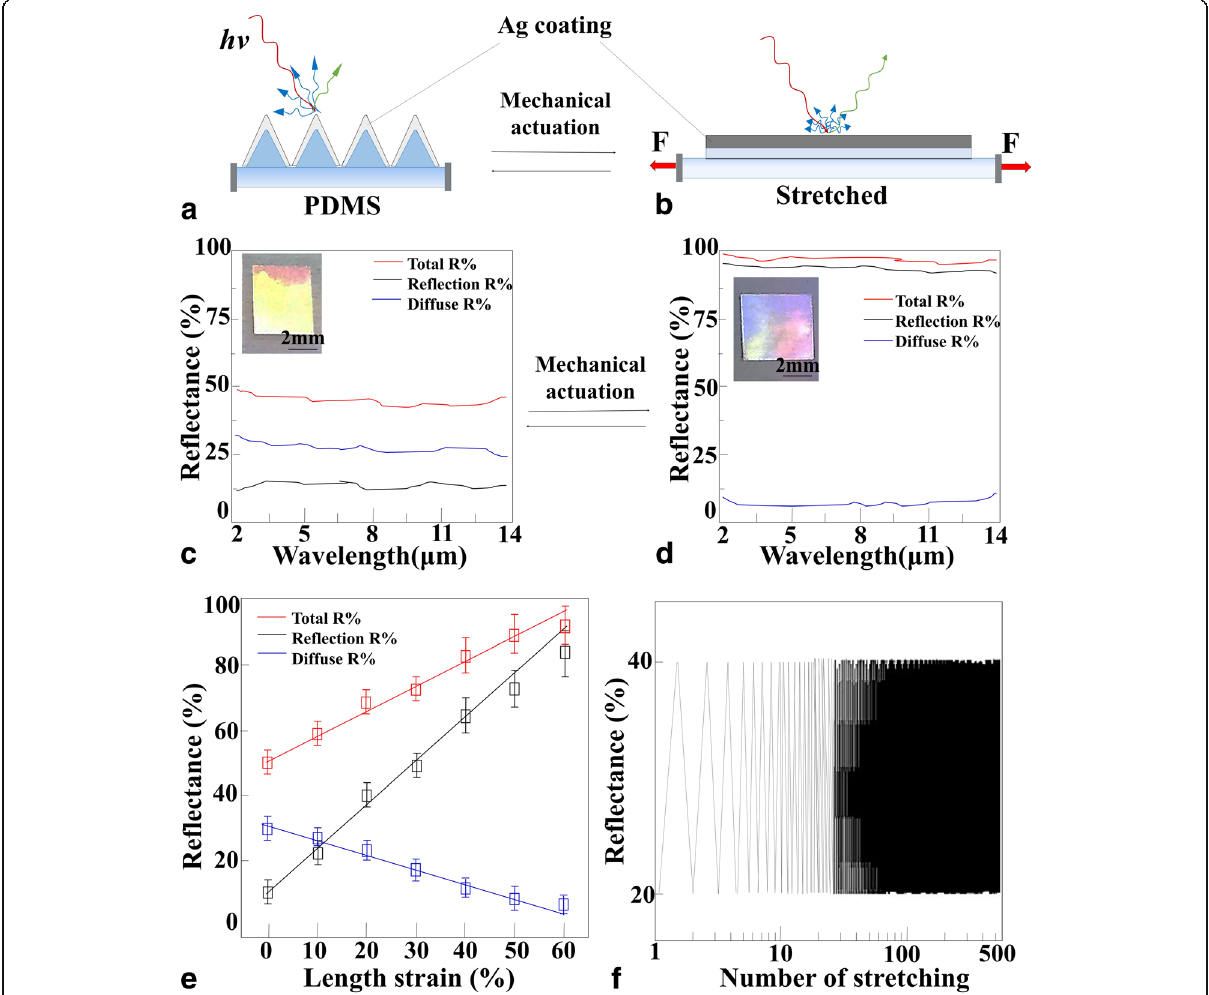
Fig. 3 Mechanical modulation of the broadband reflectance. a The change in the surface morphology and the reflection of infrared light of the Ag triangular wrinkle structures before mechanical actuation. b After mechanical actuation. c The infrared reflectance spectra of the Ag triangular wrinkle structures before mechanical actuation. The total reflectance (red traces) are shown along with their reflection (black traces) and diffuse (blue traces) components. d After mechanical actuation. e Plots of the total, reflection, and diffuse peak reflectance of the Ag triangular wrinkle structures as functions of the applied length strain. f Stability test of the Ag triangular wrinkle structures with stretching/releasing over 500